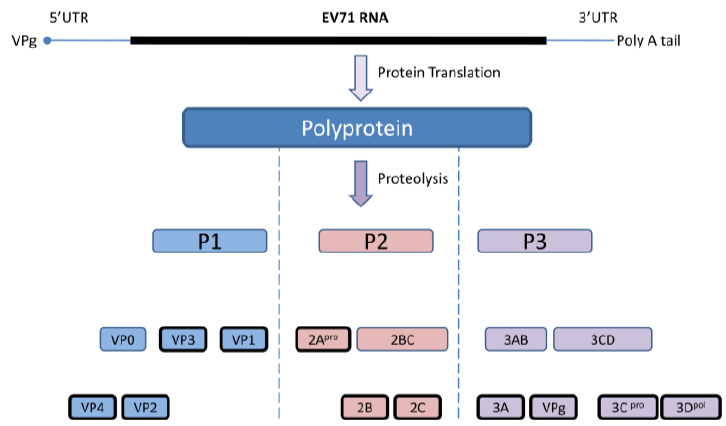
Figure 1. Diagrammatic representation of the EV71 genome and polyprotein products. Cap independent IRES driven protein translation produce a single polyprotein followed by proteolytic cleavage into partially processed products and eleven mature products. Virus encoded 3C and 2A proteases are accountable for this polyprotein processing at different stages.